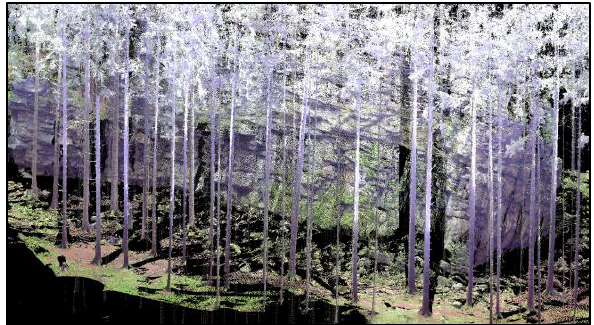
Figure 2. A preview from the source point